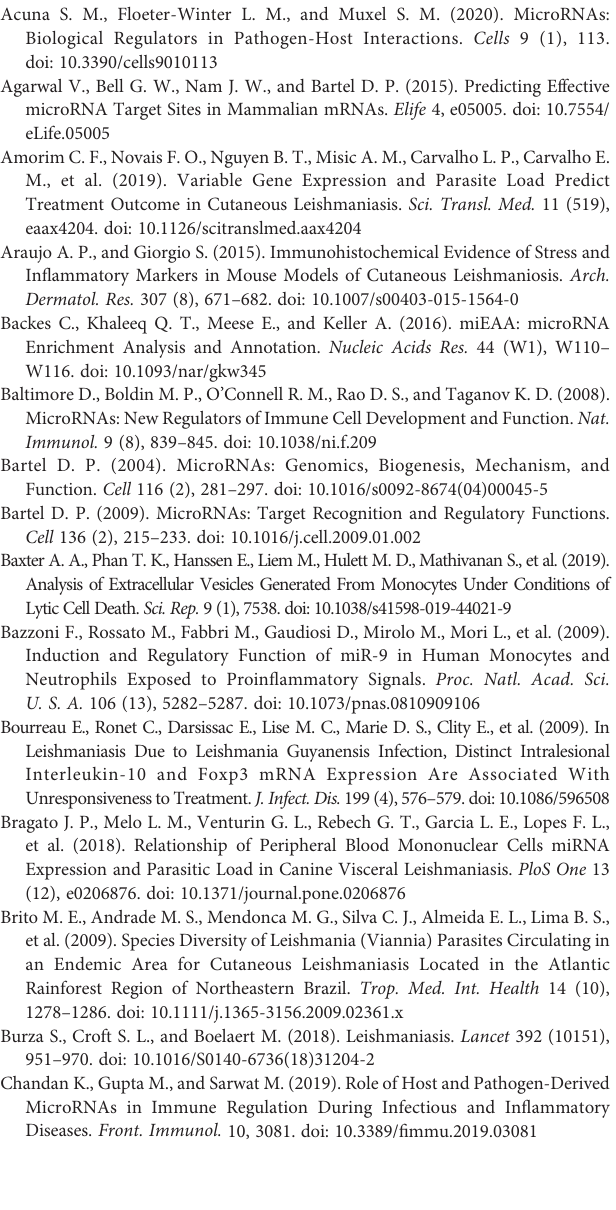
Chen J., Yan C., Yu H., Zhen S., and Yuan Q. (2019). miR-548d-3p Inhibits Osteosarcoma by Downregulating KRAS. Aging (Albany N. Y.) 11 (14), 5058